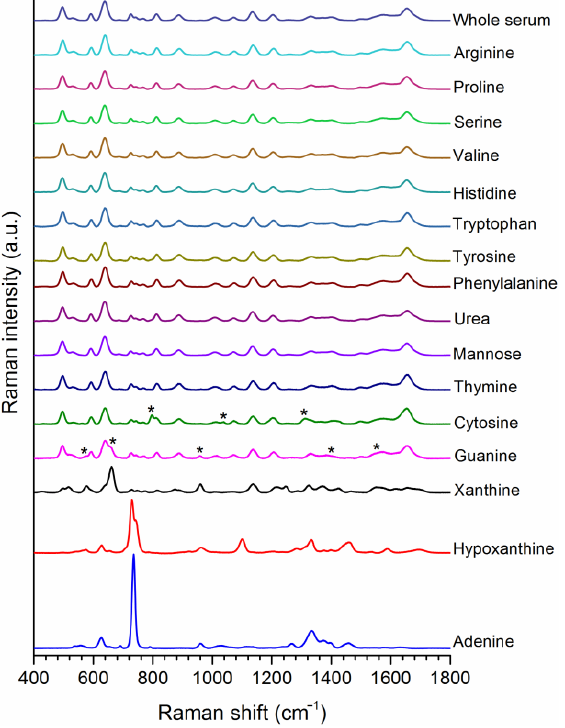
Figure 1. SERS spectra of whole serum (WS) after spiking with the indicated molecules (1 mM) found in blood serum. Star symbols indicate the bands contributed to the serum SERS spectra by the spiked metabolites.